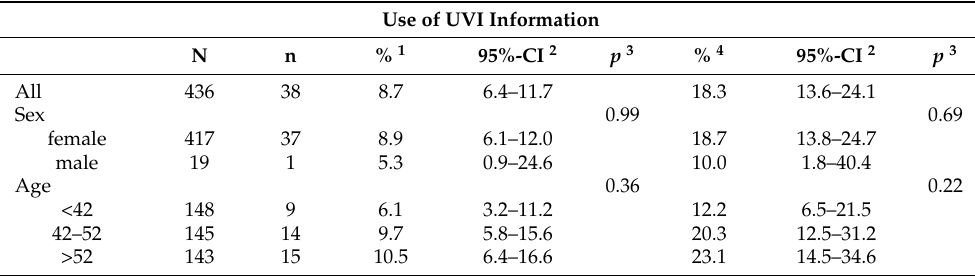
Table 2. Use of UVI information for sun protection measures at German kindergartens based on answers of directors of kindergartens (N = 436). Absolute frequencies (N = sample size; n = number of affirmative answers), proportions (%) accompanied by confidence intervals (95%-CI) and p -values ( p ) comparing proportions between